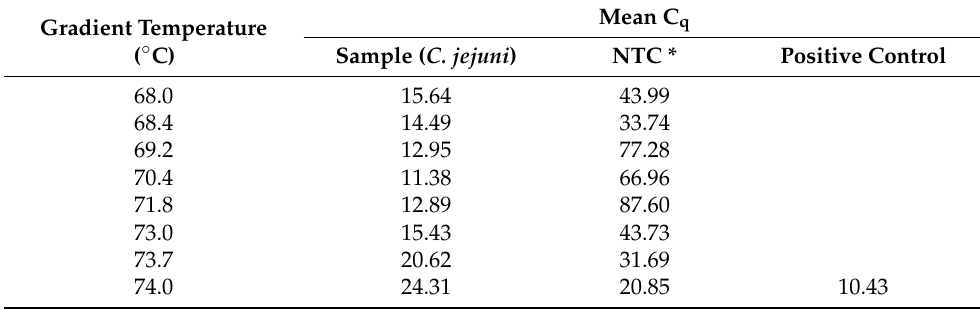
Table 2. LAMP temperature optimization using amplification